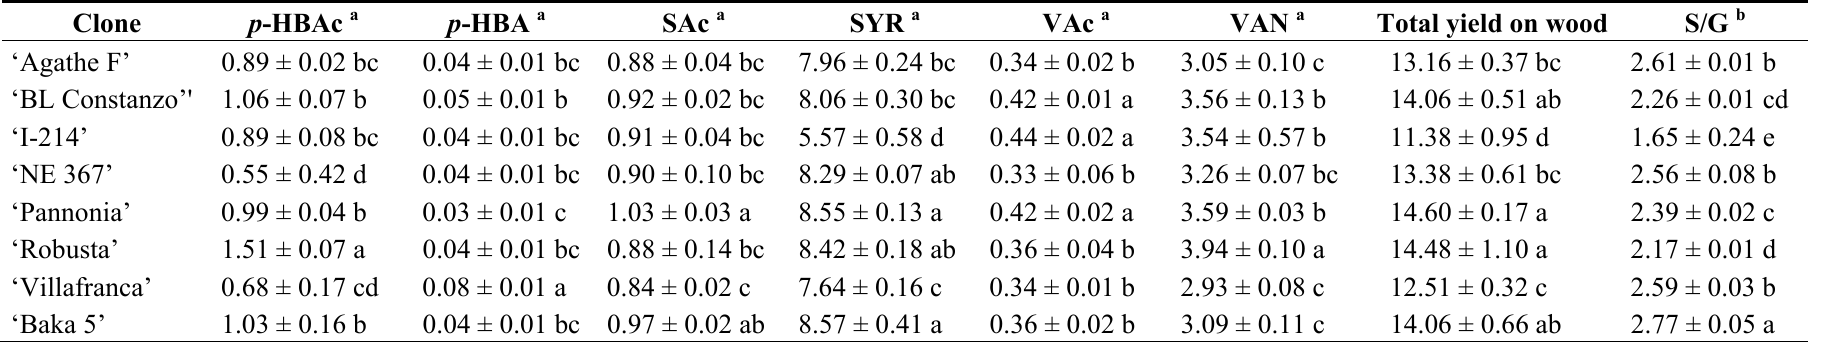
Table 5. The results of nitrobenzene oxidation (%) for the examined clones of Populus grown on the Selice experimental site. Data represent means 